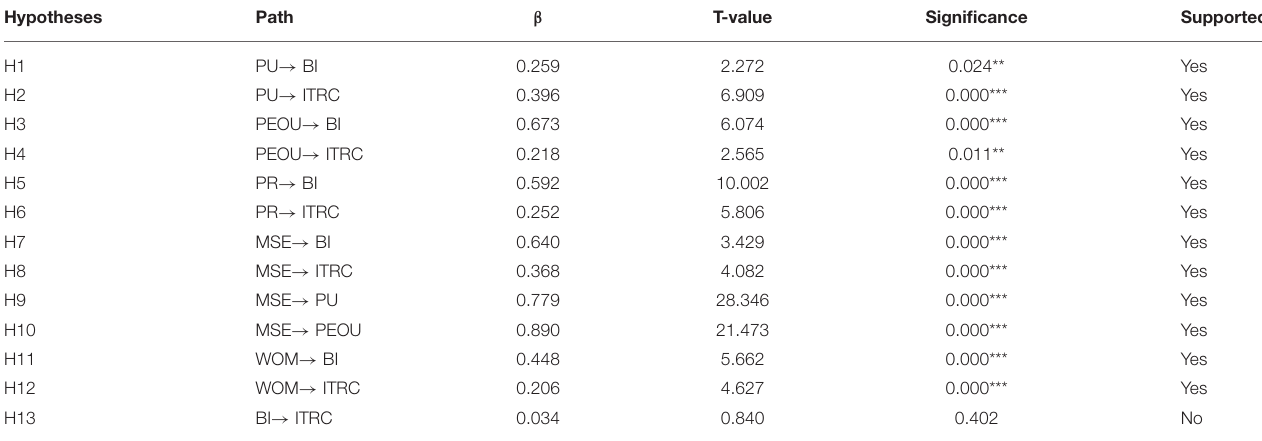
TABLE 7 | Hypotheses